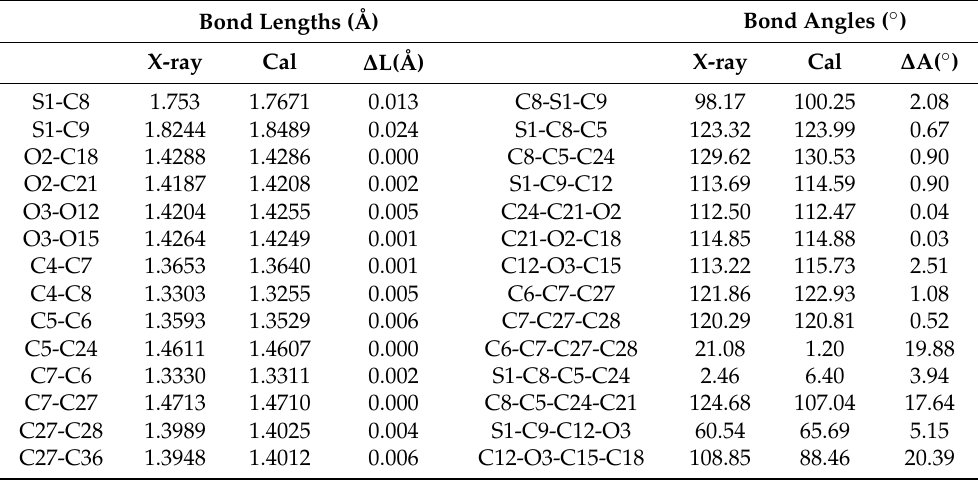
Figure 5. The optimized geometry of 3 ( left ) and its superposition (green) on the experimental structure (blue) ( right ). Table 1. The selected experimental and optimized structure parameters of 3 were obtained at the DFT/ B3LYP/6-311++G(d,p) level of